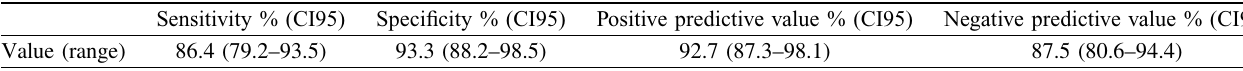
Figure 1. Study results fl ow chart. All samples ( n = 89) were analyzed according to the manufacturer ’ s instructions, i.e. , each positive sample with the Microsporidia generic PCR assay (MGa) was submitted to the Microsporidia typing PCR assay (MTa). Table 2. Performances of the Microsporidia generic assay